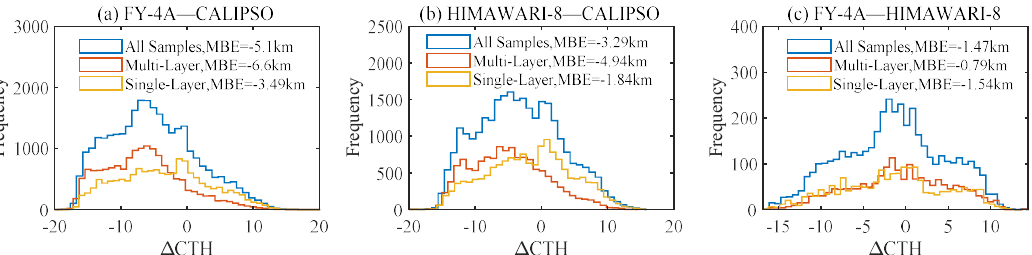
Figure 1. The ∆ CTH frequency distribution of all samples, multi-layer clouds and single-layer clouds between different satellites. ( a ) FY-4A–CALIPSO, ( b ) HIMAWARI-8–CALIPSO, ( c ) FY-4A–HIMAWARI-8.